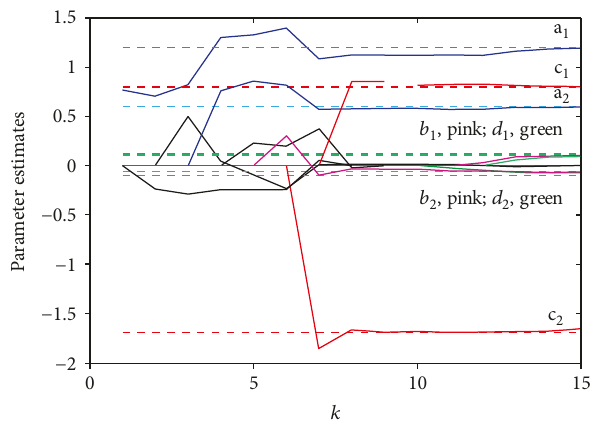
Figure 3: The parameter